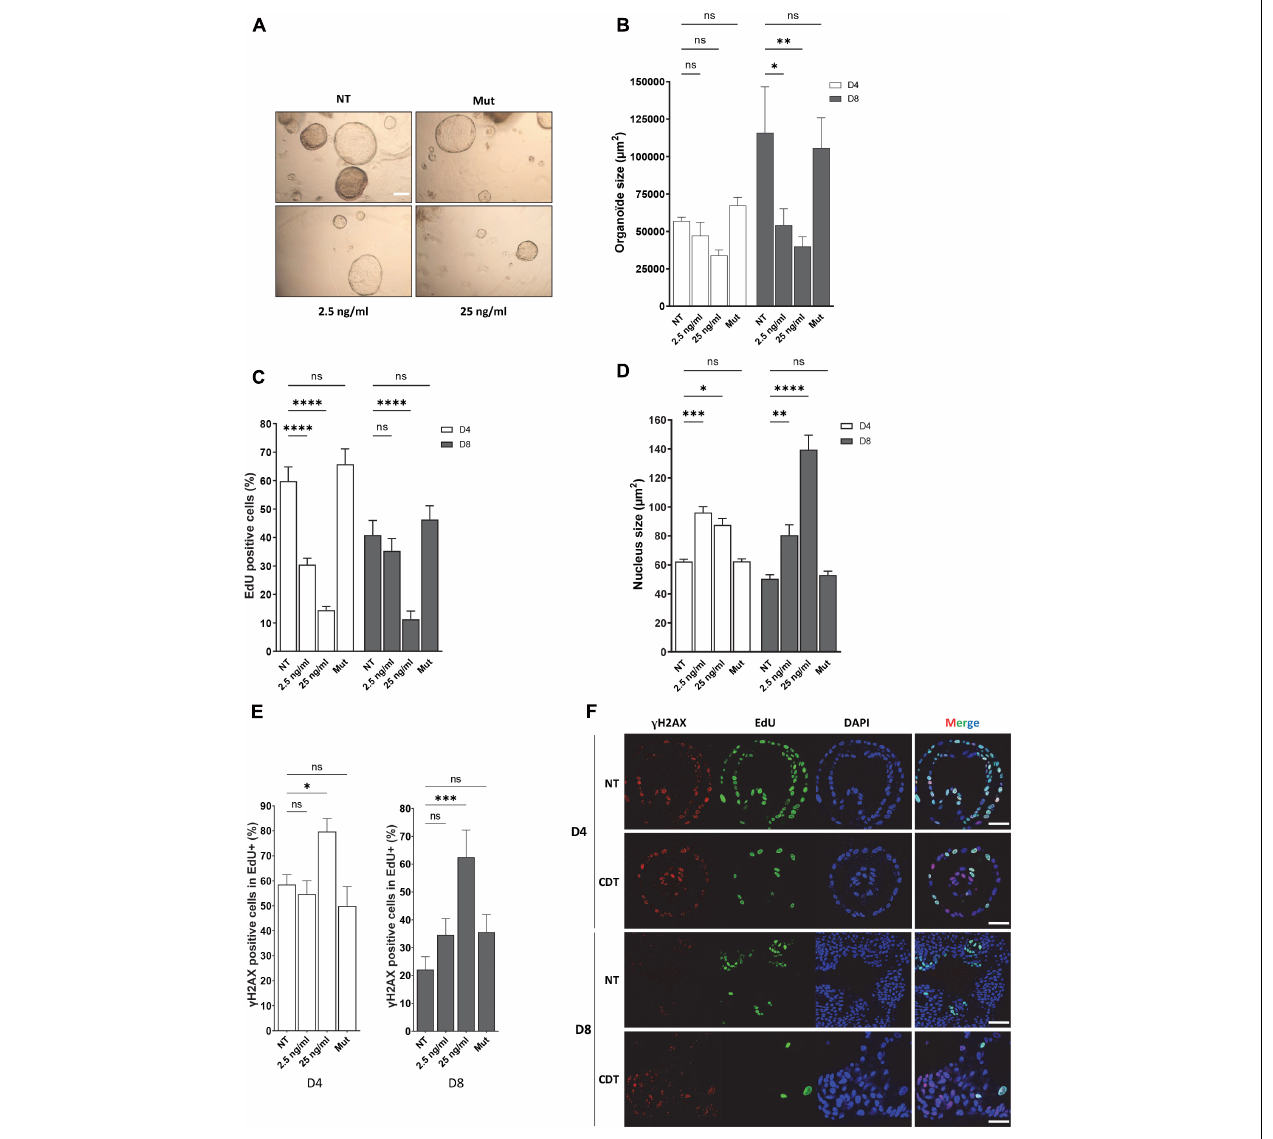
FIGURE 6 | CDT causes nuclear distension associated with DNA damage in cycling cells of human colorectal organoids leading to decrease of growth. Human colorectal crypts were treated at day 0 with wild-type (2.5 and 25 ng/ml) or catalytic inactive mutant (H153A, 25 ng/ml, Mut) of CDT from E. coli for 16 h. (A) Representative images of organoids at day 8 with a bright-field microscope. Scale bar: 200 µ m. (B) At days 4 and 8 of culture, organoid size was measured. N > 10 organoids. (C) EdU was added to the organoid culture medium for 16 h before fixation. Then, EdU was revealed and EdU-positive cells per organoid were quantified by confocal analysis. N > 6 organoids. (D) At days 4 (D4) and 8 (D8) of culture, organoid nucleus size was analyzed by confocal microscopy. N > 6 organoids. (E,F) At day 4 (D4) or 8 (D8), EdU was added to the organoid culture medium for 16 h before fixation and revealed. Then, γ H2AX immunostaining was performed and γ H2AX-positive cells in proliferating cell population (EdU + ) from organoids were quantified. N > 6 organoids. (F) Representative images of EdU (green) and γ H2AX (red) immunostaining in human colorectal organoids at days 4 (D4) and 8 (D8) treated or non-treated (NT) with 25 ng/ml of E. coli CDT were obtained from confocal analysis. Scale bar: 50 µ m (mean ± SEM of at least three independent experiments) [ ∗ P < 0.05, ∗∗ P < 0.01, ∗∗∗ P < 0.001, ∗∗∗∗ P < 0.0001 versus non-treated (NT); ns, not